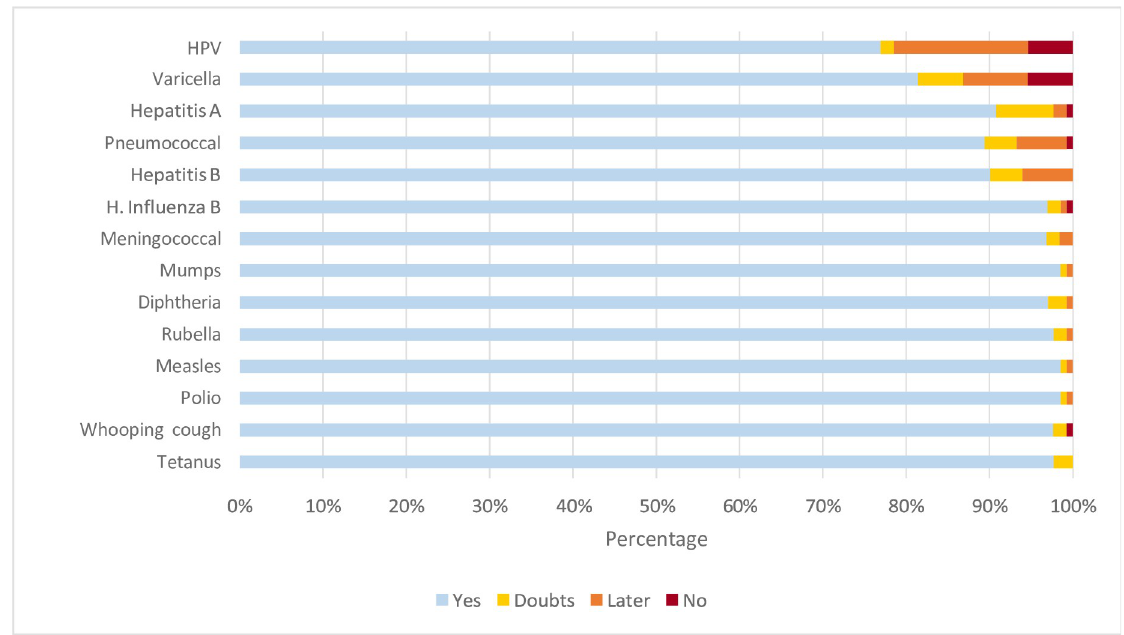
Fig 1. Paediatric nurses responding “yes, doubts, later, or no” to vaccinating their own children (%). Barcelona. 2016–17 (N =